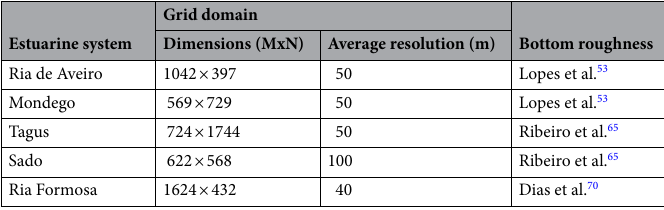
Table 4. Main parameters of the Delft3D numerical